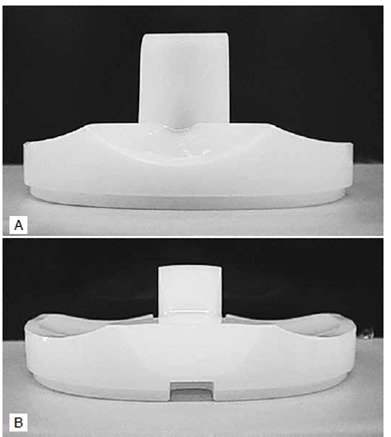
(A) Tibial polyethylene inserts of a constrained condylar prosthesis. Legacy Constrained Condylar Knee prosthesis (LCCK; Zimmer, Warsaw, IN, USA); (B) Posterior stabilized prosthesis (PS). Legacy Knee Posterior Stabilized prosthesis (LPS; Zimmer, Warsaw, IN, USA). An insert of a constrained condylar prosthesis is characterized by the high and broad central post that fits closely against the femoral cam, providing, thus, increased stability.